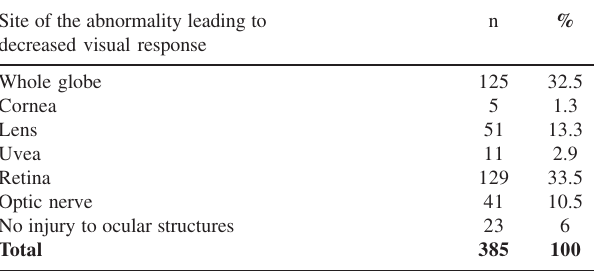
Table 2 - Distribution of the pediatric population with decreased visual response by ophthalmologic